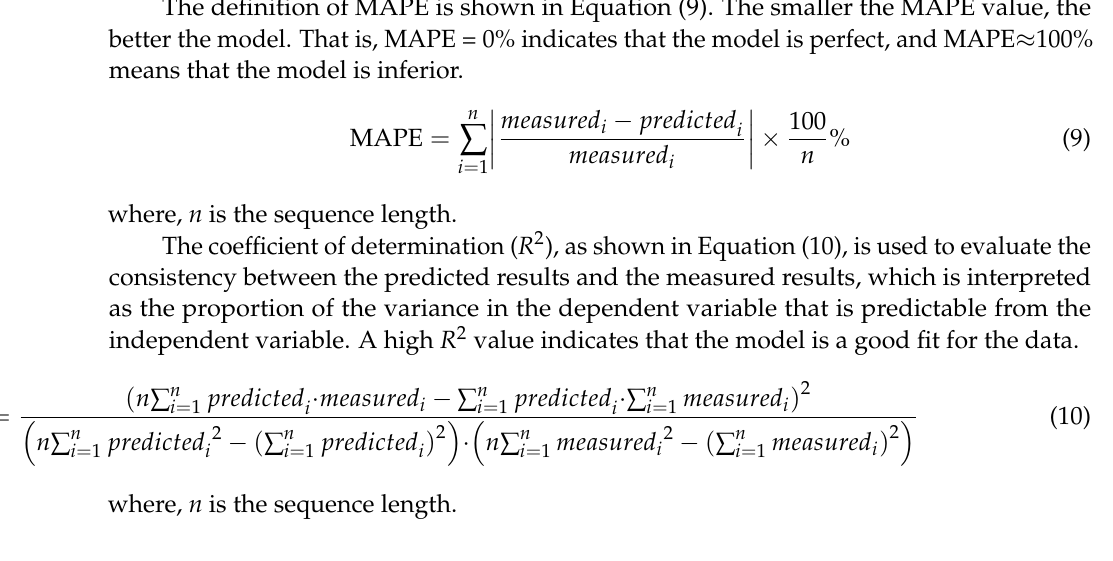
Figure 8. History curve of building settlement.